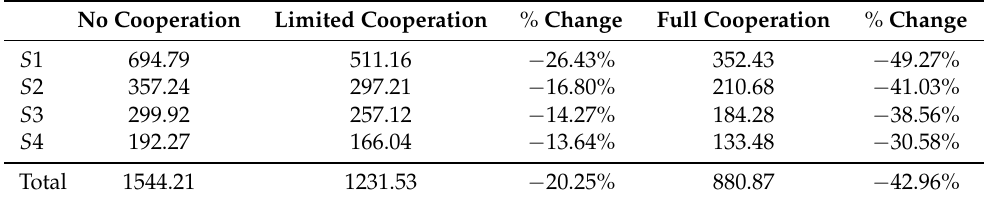
Table 3. Average distance driven (km) in the 100 replications for non-, limited, and full cooperation settings for each supermarket.